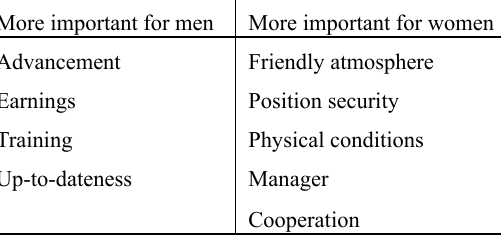
Table 3. Gender Difference in “Work